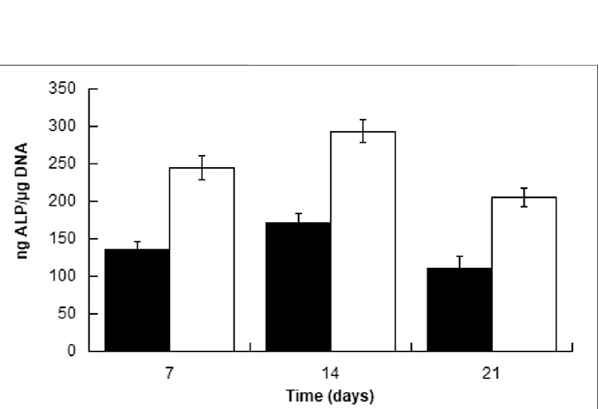
FIGURE 7 | Normalized ALP activity (ALP/DNA) measured for 300PEOT55PBT45-PCL (black) and BCP-containing 300/55/45-PCL (white) scaffolds at different time